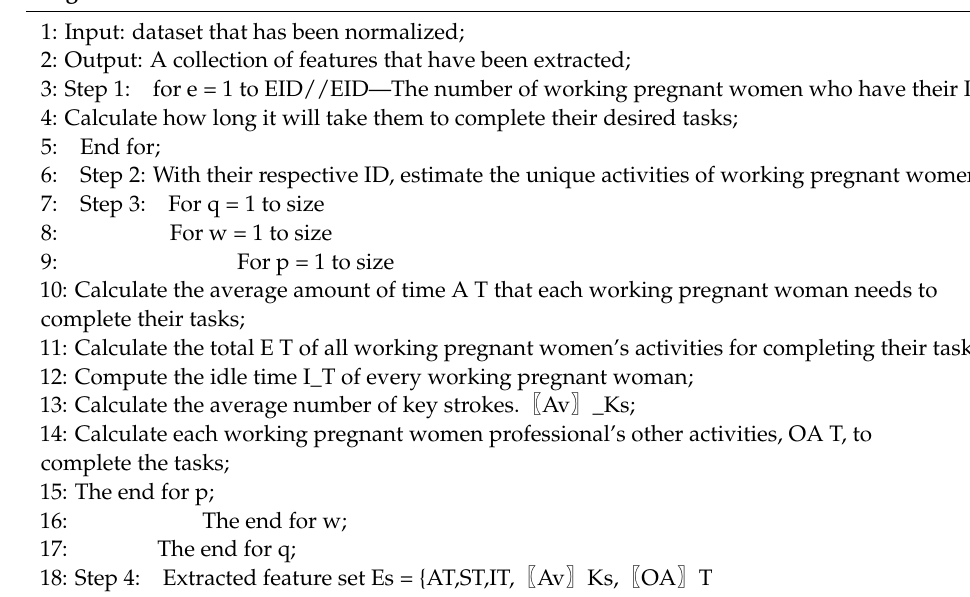
Algorithm 1 Extraction of